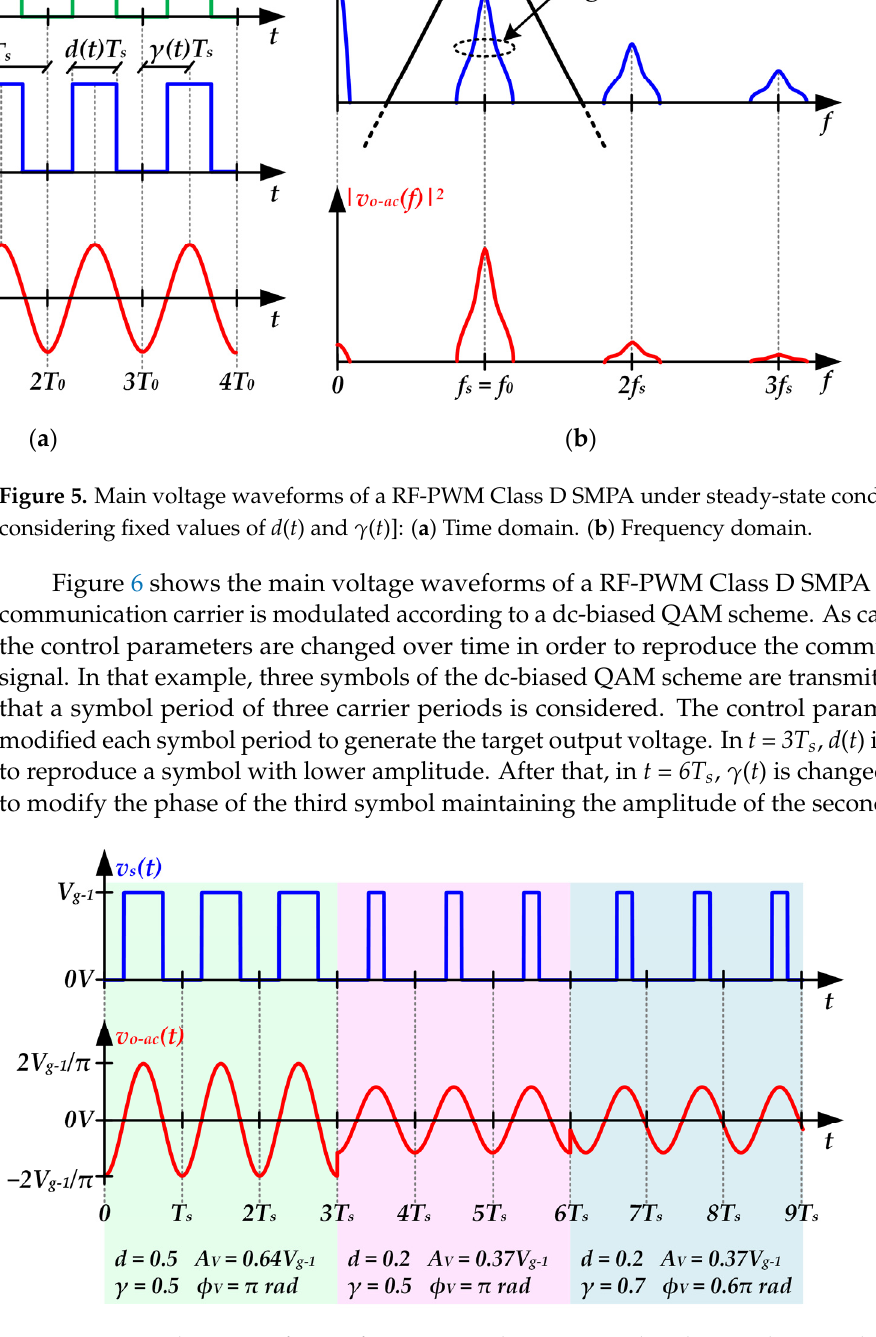
Figure 6. Main voltage waveforms of a RF-PWM Class D SMPA that changes the control parameters over time in order to reproduce a dc-biased QAM scheme.